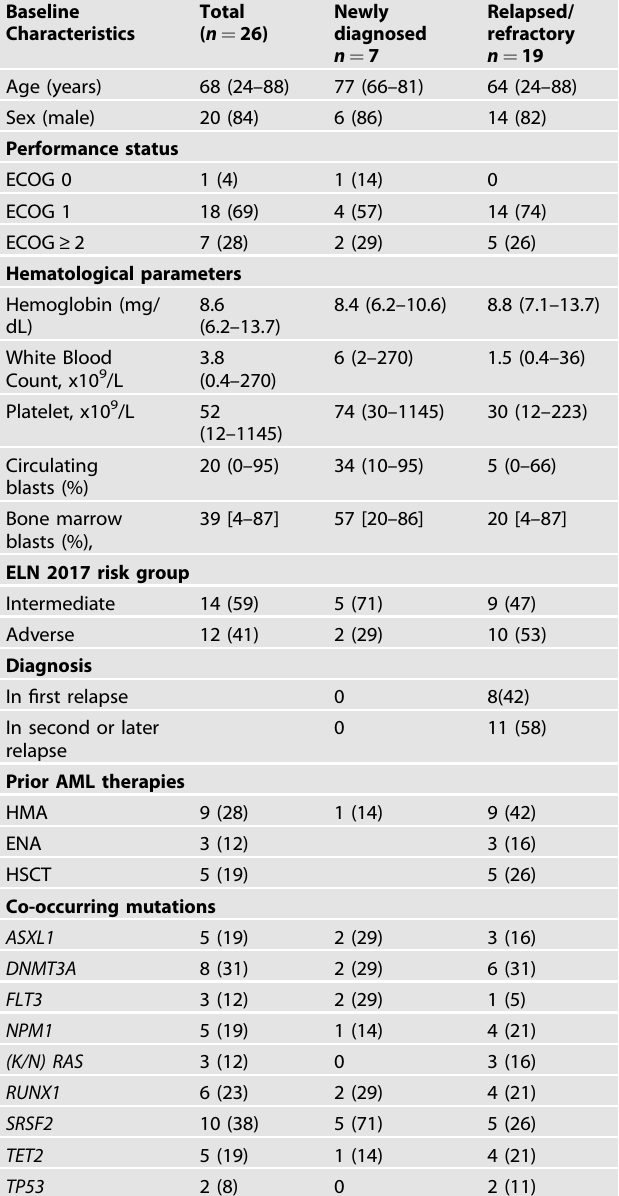
Table 1. Baseline Demographics. Table 2. Outcomes in newly diagnosed and relapsed/refractory patients with IDH2 mutant acute myeloid